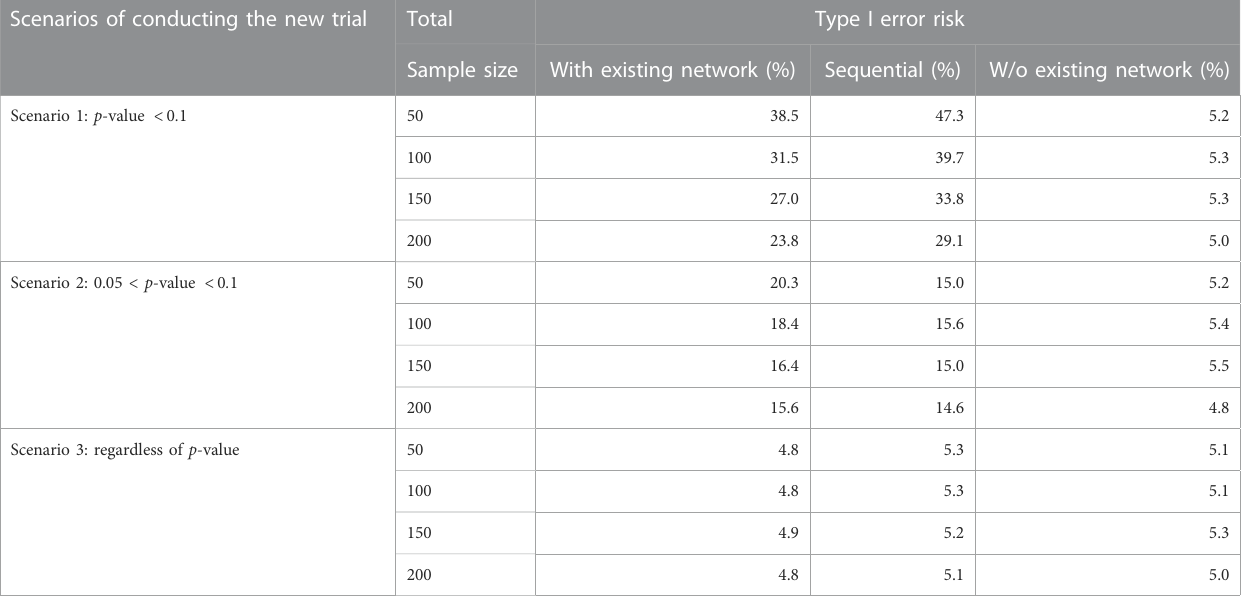
TABLE2SimulationStudy1:TypeIerrorrisk(100,000simulation)underdifferentscenariosofconductingnewstudyandthreeanalysismethods(TSA,withorw/o existingnetwork).Inthesimulation,theeffectsizeis0betweenTRIMandCEFTH.The p -valueinthetablereferstothe p -value( H 0 :theeffectsizeis0betweenTRIM and CEFTH) in the existing